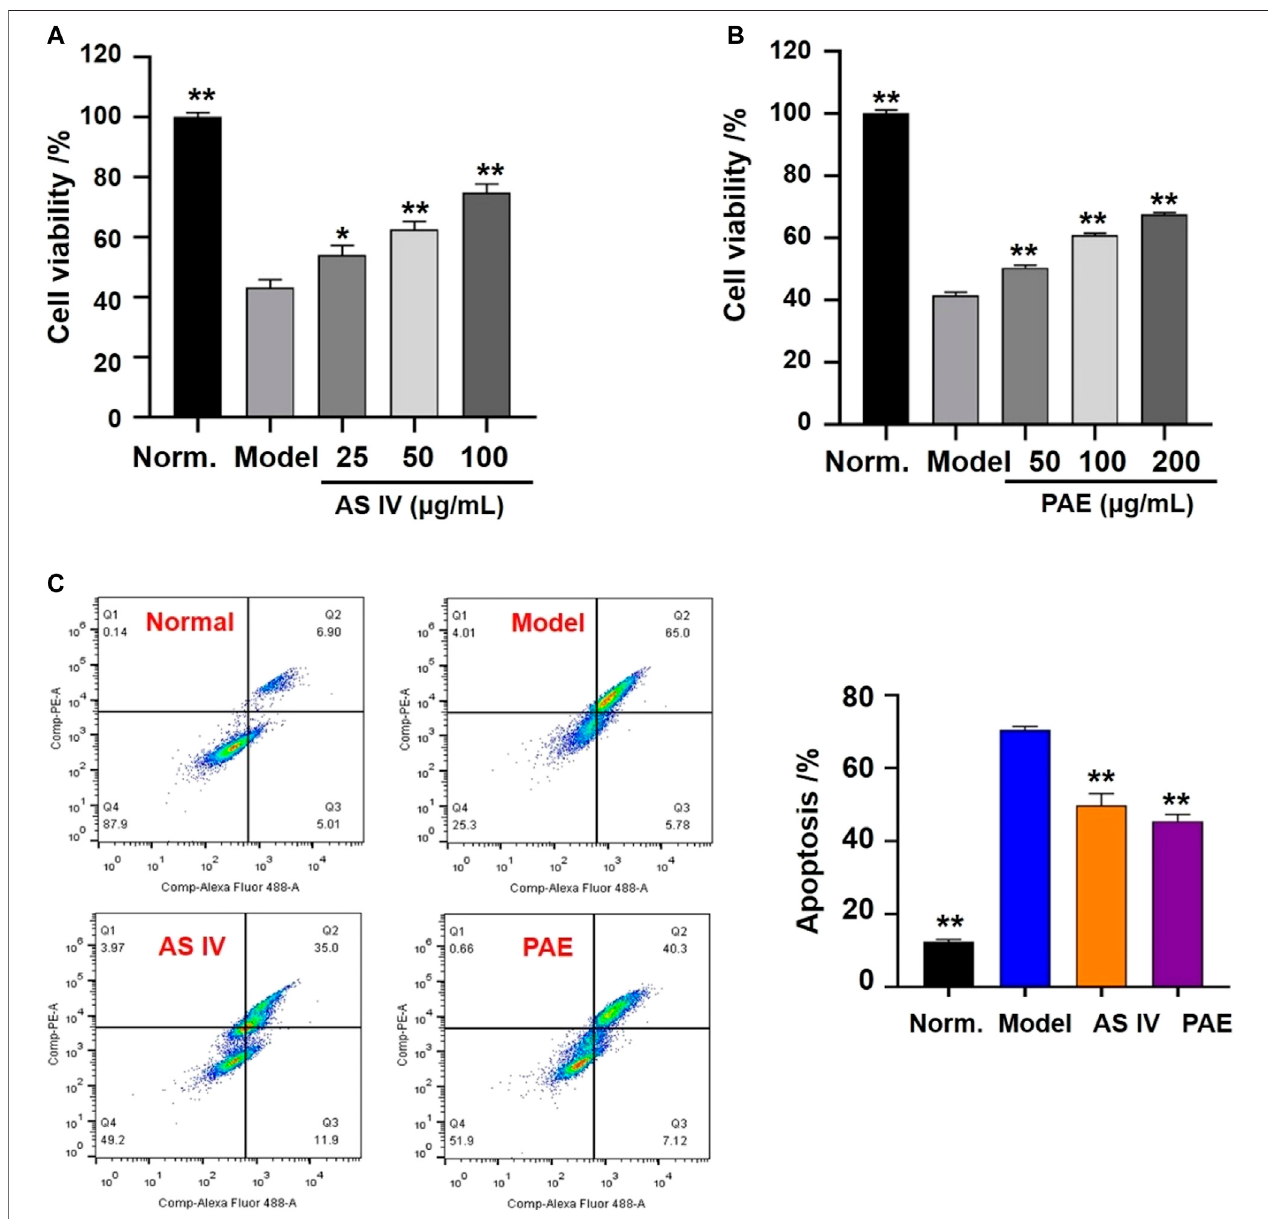
FIGURE8 | Effects of themain active components (AS IV and PAE)on cell viability and apoptosis in H 2 O 2 -stimulated H9c2 cells. (A) Effects ofAS IV on cellviability of H2O2-stimulated H9c2 cells under different concentration (25, 50 and 100 μ M). (B) Effects of PAE on cell viability of H2O2-stimulated H9c2 cells under different concentration(50,100and200 μ M). (C) Apoptoticassayby fl owcytometry.Thevalueswererepresentedasthemean±SD( n =3).* p < 0.05,** p <